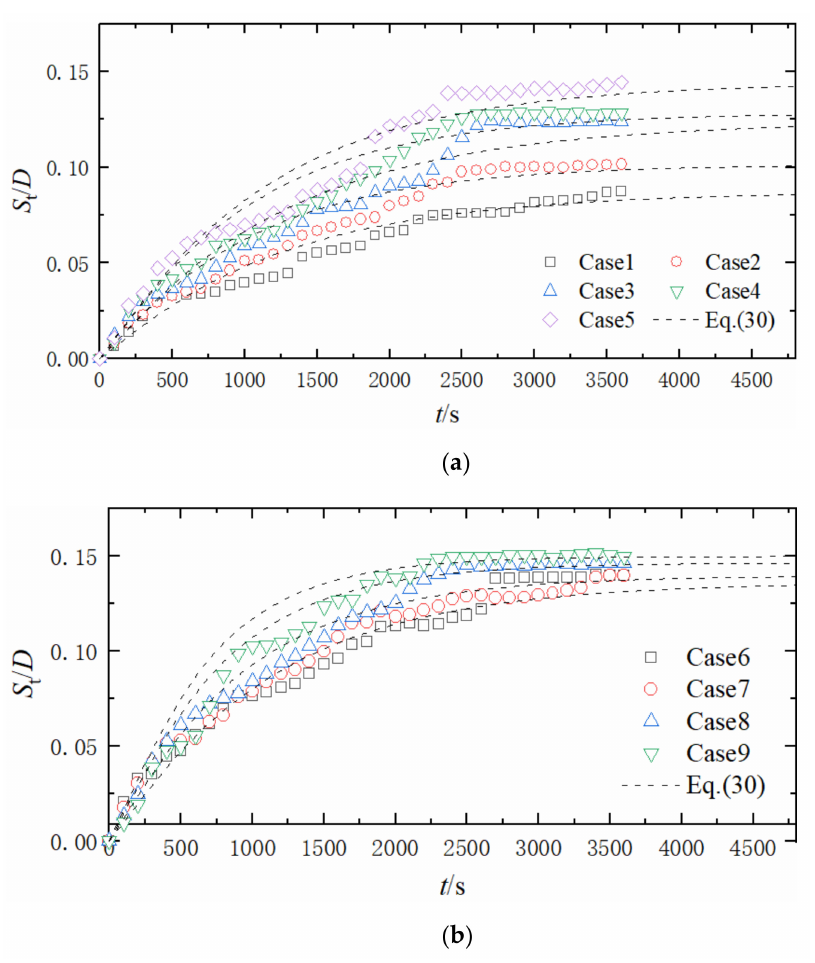
Figure 8. Time evolution of scour for case 1–9: ( a ) Case 1–5; ( b ) Case